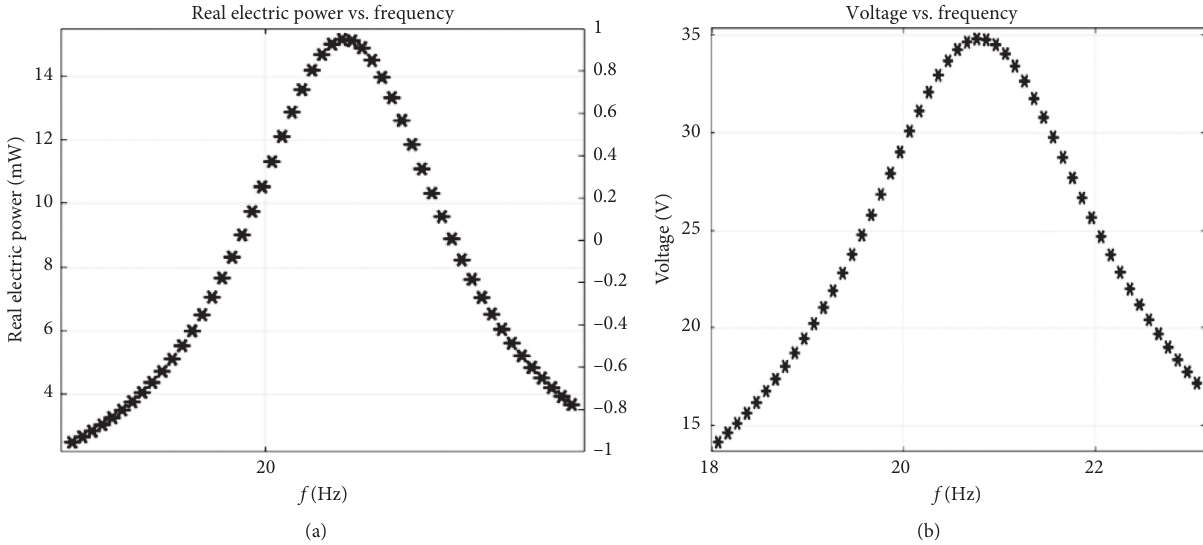
Figure 5: Electric power output vs. vibration frequency of the first trapezoidal bimorph two-piece design (a). Voltage vs. vibration frequency of the first trapezoidal bimorph two-piece design (b). W 1 is 40mm, and W 2 is 18mm. The full-width half-maximum is 2.5Hz. The quality factor is 28. The structure loss factor is 0.025. The damping ratio is 0.017. The optimal resistance is 0.08M Ω . The length of the beam L is 60mm, the thickness of T piezo is 0.3 mm, and the thickness of the brass layer T s is 0.05